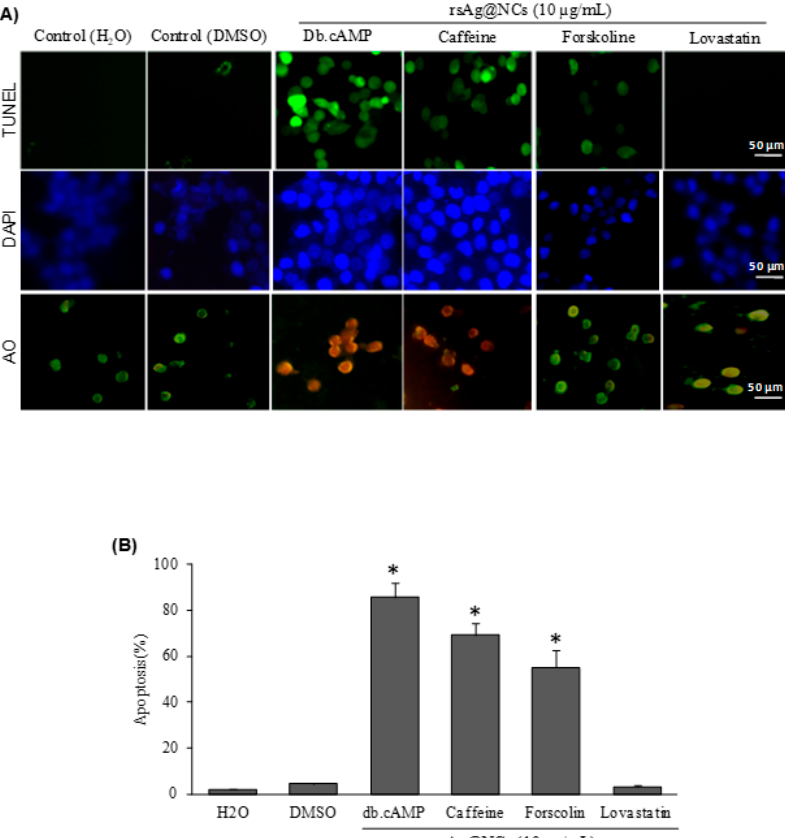
Figure 5. Pharmacological manipulation of the Ras signaling pathway of FCZ-resistant C. albicans NBC099. ( A ) NBC099 cells grown on glass cover slides and treated with H 2 O of 0.2% DMSO (as the vehicle control), dibutyryl cAMP (db.cAMP; in water), caffeine (in water), forskolin (in DMSO), or lovastatin (in DMSO). After incubation for 30 min at 37 °C, cells were further treated with 10 µg/mL of rsAg@NCs for 24 h. Immunofluorescence detection of apoptosis was observed by using TUNEL, AO, and DAPI staining assays. For the TUNEL assay, cells were washed and permeabilized. DNA ends of cells were labelled by using the APO BrdU TUNEL Assay Kit, and cells were observed under a fluorescence microscope. Cells were stained with 5 µg/mL and 1 µg/mL of AO and DAPI, respectively. Subsequently, cells were analyzed by fluorescence microscopy. ( B ) To quantify apoptotic cell death, treated or untreated cells were also analyzed by flow cytometry, using the TUNEL assay kit. Water or DMSO (final concentration of < 0.2%) was used as a vehicle control for drug treatments. Each reported value represents the mean ± SE from three independent experiments (* p < 0.001, compared with the untreated control).